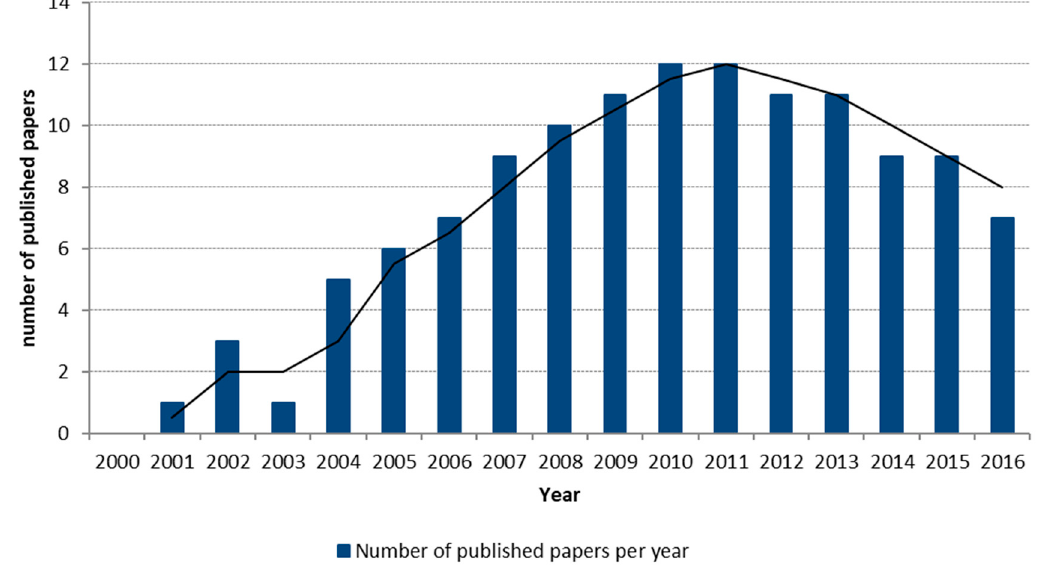
Figure 3. Total number of published articles in the field of electricity price forecasting in the observed sample of scientific articles.